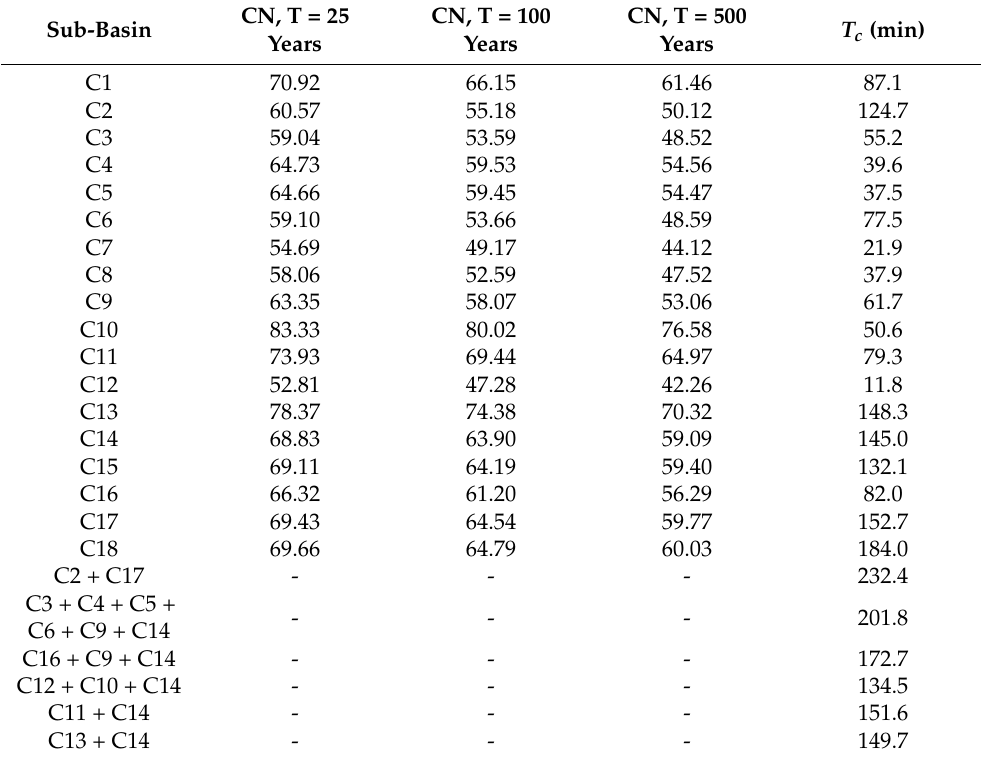
Figure 9. Hyetographs for each return period analyzed: ( a ) 25 years; ( b ) 100 years; ( c ) 500 years. Table 4. Curve Number (CN) and concentration time ( T c ) at each sub-basin and for different